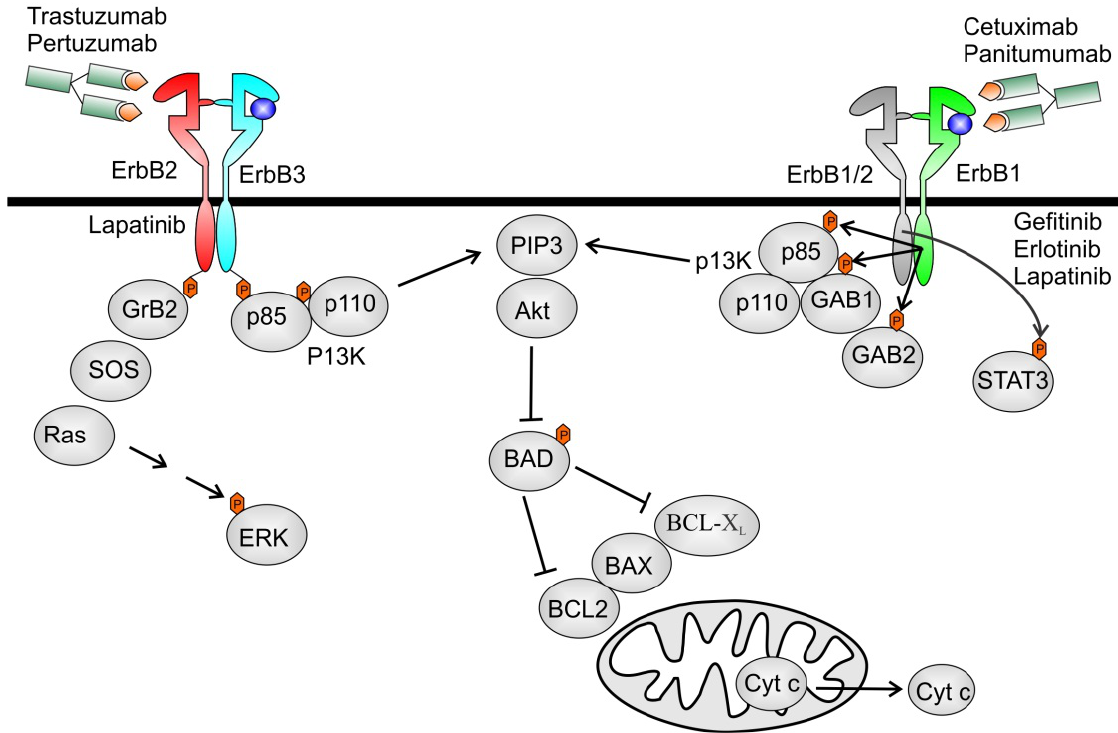
Figure 2. Mechanisms of ErbB signaling and inhibition in tumour cell. Oncogenic signaling incancer cells can be mediated by overexpressed ErbB2, ErbB2 homodimers or ErbB2/ErbB3 heterodimers, and also by ErbB1 homodimers or ErbB1/ErbB2 heterodimers. These events trigger signaling through a complex array of intracellular pathways that initiate and control a range of cellular processes. Out of many signaling event in a network, three key signaling pathways are the Ras-Erk (mitogen-activated protein kinase (MAPK)), the phosphatidylinositol 3-kinase (PI3K)–AKT and the Janus Kinase (JAK-STAT) pathway. The monoclonal antibodies (mAbs) cetuximab, panitumumab, trastuzumab and pertuzumab act extracellulary by blocking ligand binding and/or receptor dimerization. The small molecule tyrosine kinase inhibitors (TKI) gefitinib, erlotinib and lapatinib compete with ATP in the tyrosine-kinase domain of the receptor and block tyrosine kinase activity. Both interrupt downstream signaling. In addition to inhibiting ErbB signaling, mAbs might also mediate anti-tumour effects through antibody-dependent cell-mediated cytotoxicity (ADCC). Inhibition of ErbB2 by trastuzumab impairs all downstream events, in particular reversing BCL2-antagonist of cell death (BAD) inhibition, leading to a decrease in anti-apoptotic Bcl-xL expression. This leads to a destabilization of the mitochrondrial membrane and ATP depletion, cytochroom c release and caspase activation. Only signaling through these three pathways and known subcellular processes are shown here for